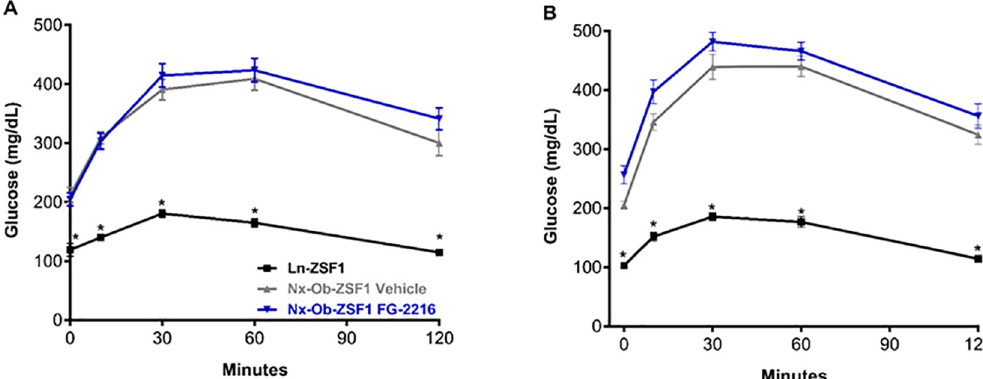
Fig 5. FG-2216 did not affect glucose tolerance in Nx-Ob-ZSF1 rats. Blood glucose levels during oral glucose tolerance tests after 6 weeks ( A ) and 14 weeks ( B ) of treatment. Values represent mean ± SEM (n = 8–12). � P < 0.05 vs . Nx-Ob-ZSF1 Vehicle (Bonferroni